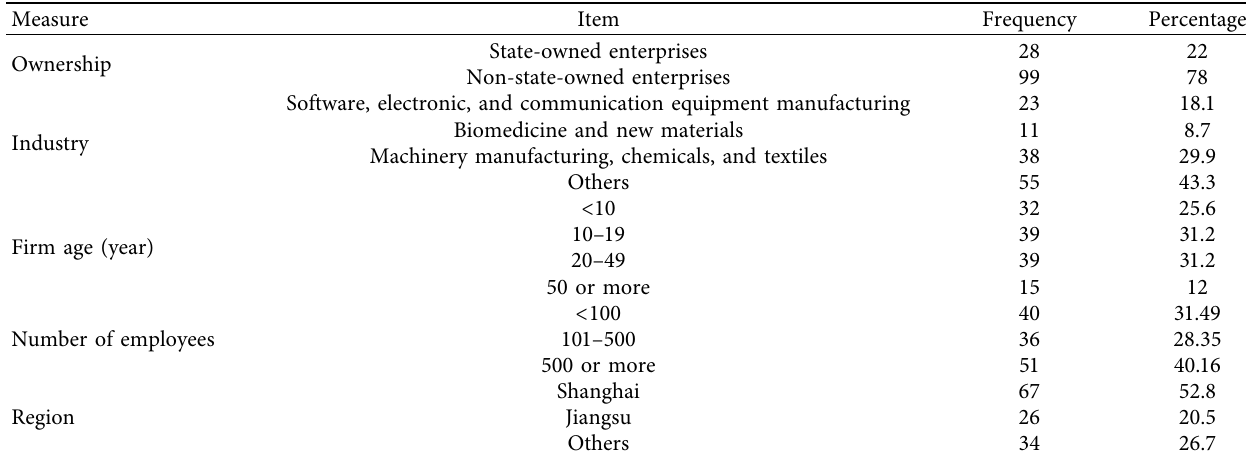
Figure 1: Conceptual Table 1: Sample and population demographics.